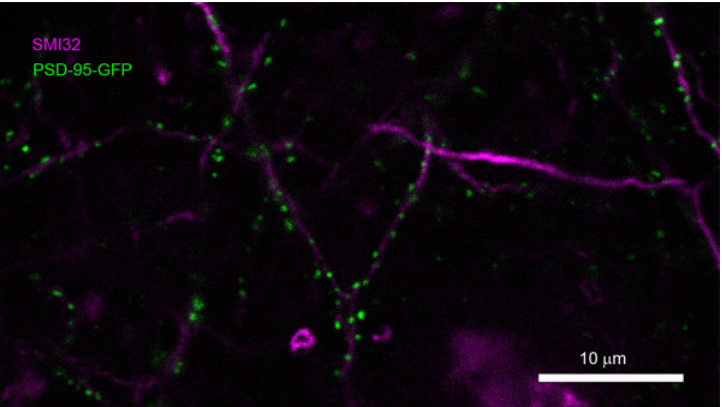
Fig 1. Labeling excitatory synaptic input on retinal ganglion cells. The synaptic sites were labeled with PSD-95-GFP that was delivered into retinal ganglion cells by in-vivo transfection with AAV2 (green). The dendrites were counterstained with an antibody against neurofilament (SMI32,